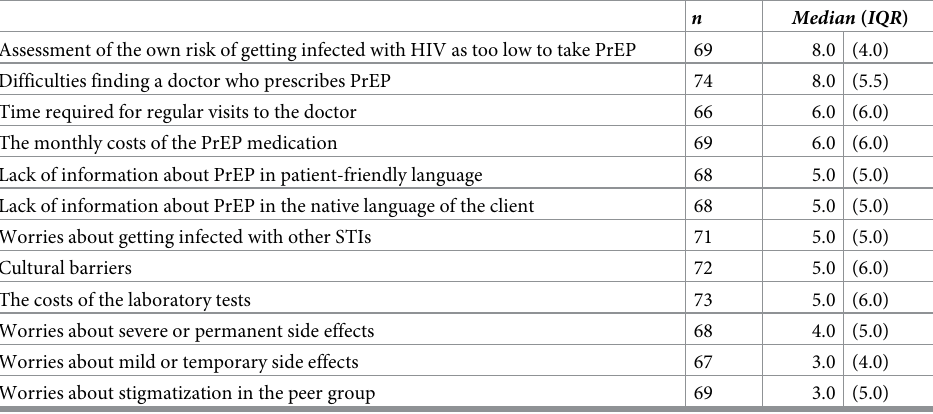
Table 7. Barriers for patients to initiate PrEP as perceived by participating